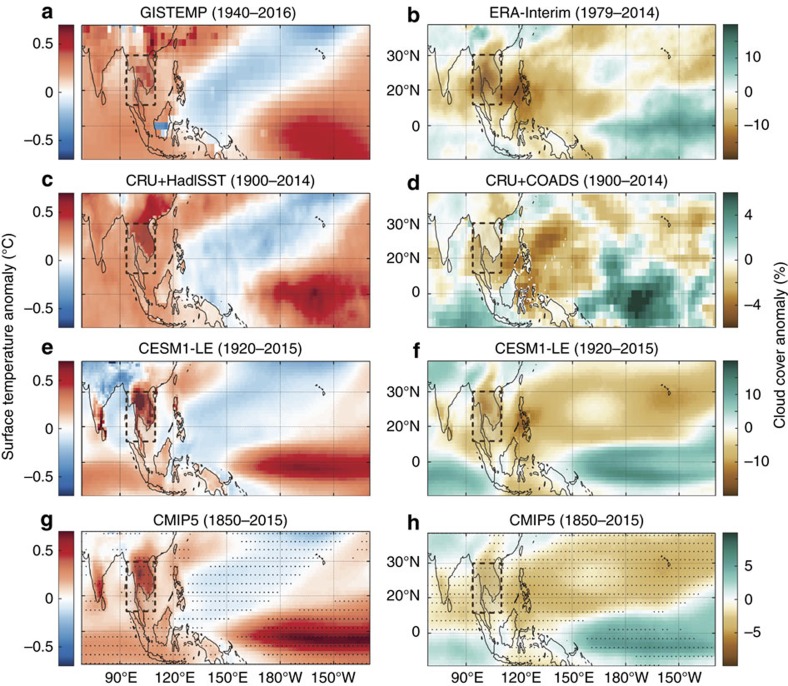
Post-Niño April composites.Composites of (a–d) observed and (e–h) simulated (left) SAT and (right) cloud cover anomalies during April after El Niño events. The SAT observations are from the (a) GISTEMP datas et (1940–2016) and (c) CRU and HadISST1.1 data sets (1900–2014) whereas the cloud cover observations are from the (b) ERA-interim reanalysis data set and (d) the CRU and ICOADS data sets. The simulated composites are from (c) the CESM1-LE model with data from 1920 to 2015 (ref. 22) and the CMIP5 Ensemble from 1850 to 2015 (ref. 23; stippling indicates agreement between majority of the ensemble members). Composites were produced by averaging April anomalies after the peak of El Niño events where the simulated composites are the average composite among the 39 CESM1-LE members. El Niño events were identified as those years with peaks of the Niño-3.4 SST index larger than 0.5 standard deviations in each (observational and simulated) data set. The CESM1 composite SAT anomalies are scaled down by a factor of 0.45 over both land and ocean so that the April composite SST anomalies averaged over the Niño-3.4 region agree in magnitude with the observed April HadISST1.1 composite. No scaling was performed for the cloud cover data simulated by CESM nor for the SAT and cloud cover simulations from the CMIP5 ensemble.